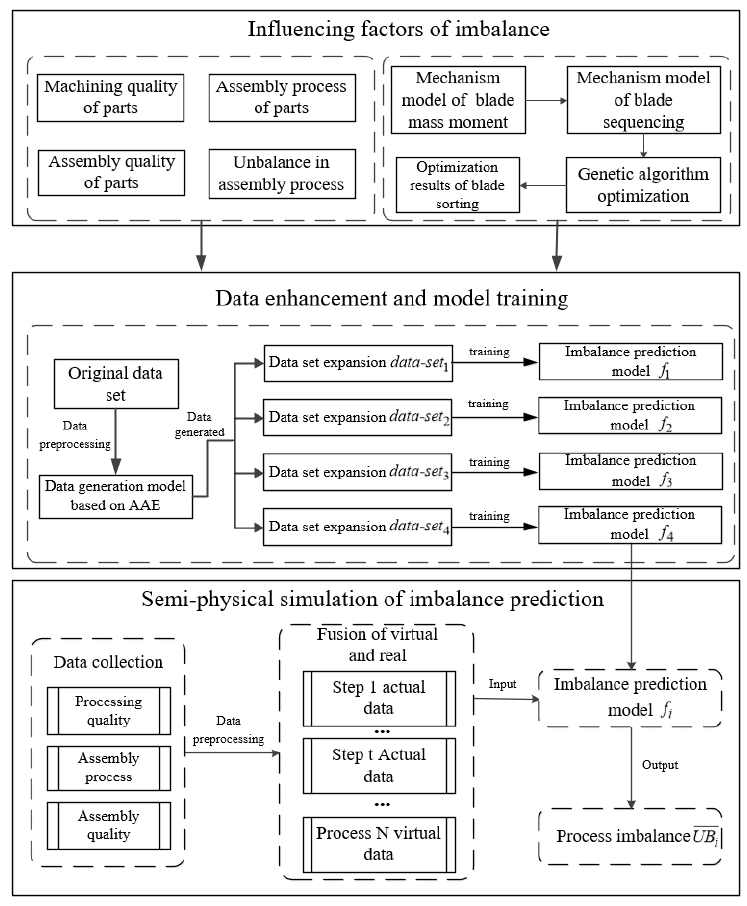
Figure 1. Rotor imbalance prediction method.